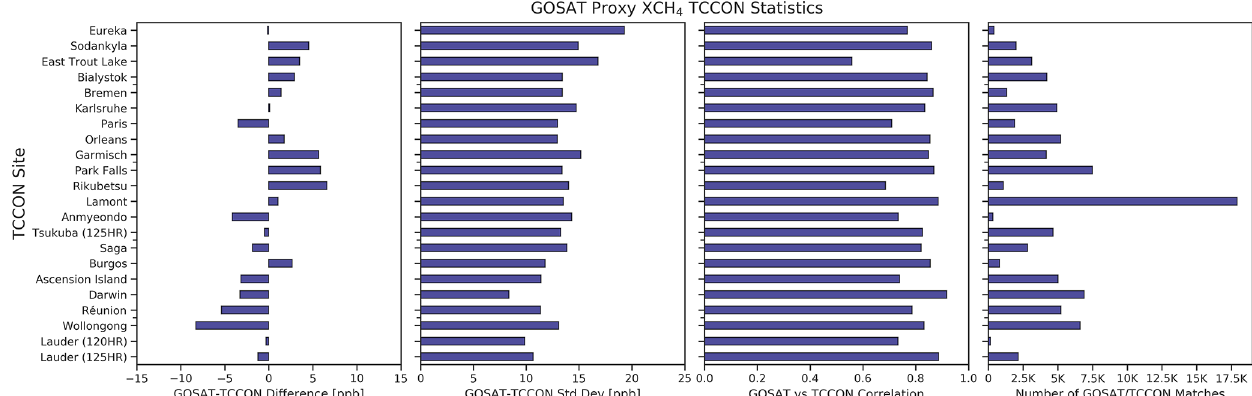
Figure 6. Summary of the statistics from Fig. 5 comparing the GOSAT Proxy XCH 4 data to the TCCON measurements for each TCCON site. Panels show the GOSAT–TCCON difference, the GOSAT–TCCON standard deviation, the correlation coefficients between the GOSAT and TCCON data and finally the number of co-located GOSAT–TCCON